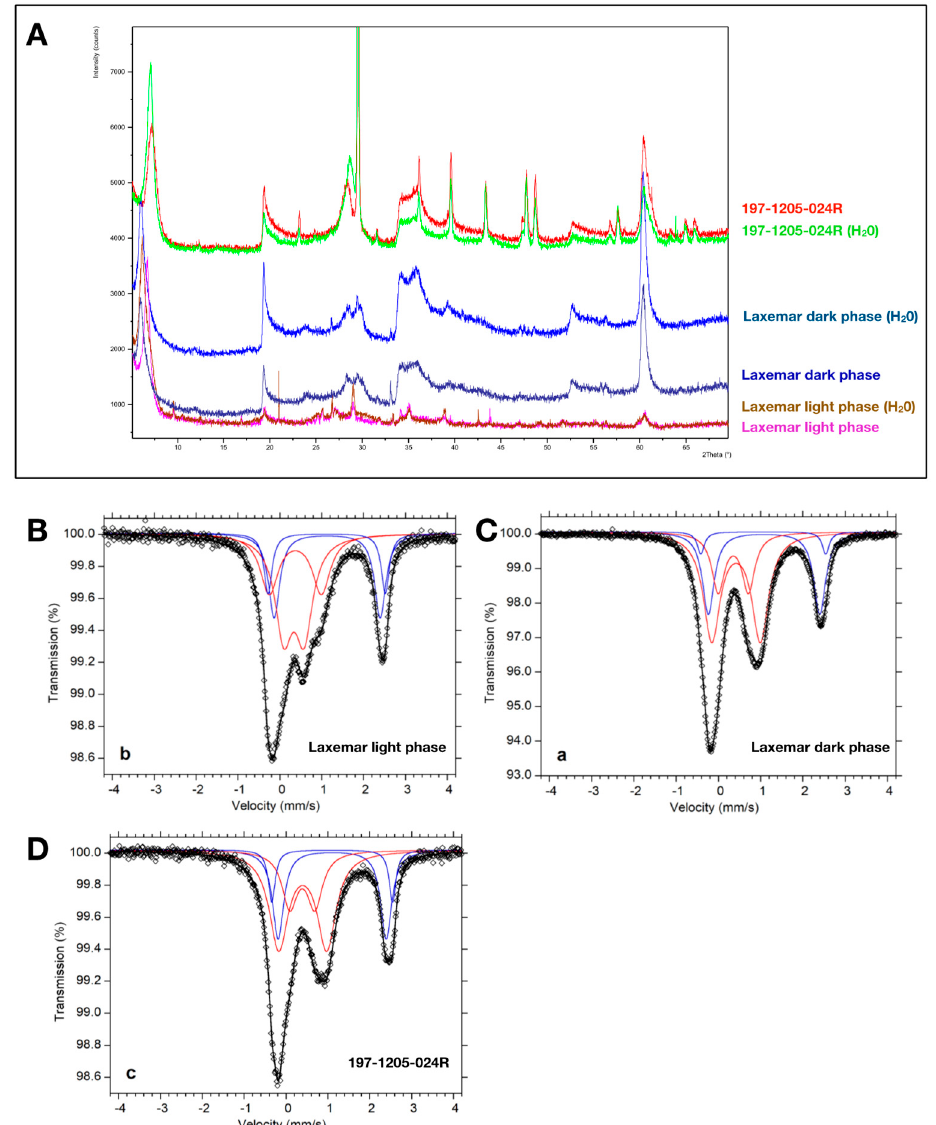
Figure 3. XRD ( A ) and Mössbauer spectra ( B – D ) of sample 1205A-024R (Nintoku seamount, clay mineralized hyphae) and two fungal biofilm samples (light and dark) from Laxemar, Sweden. ( A ) Summary of all XRD spectra encoded by color showing XRD peaks most closely related to smectites, in particular montmorillonite (there are also some peak matches with the smectite-group mineral saponite). ( B ) Mössbauer spectrum of light-colored clay mineralized fungal filaments from Laxemar. Diamonds represent the measured spectrum; the thick solid line represents the sum of the two fitted doublets (thin lines) assigned to Fe 3 + and Fe 2 + (Fe 2 + / Fe tot : 33.9%). ( C ) Mössbauer spectrum of slightly altered dark-colored clay mineralized biofilm from Laxemar. Diamonds represent the measured spectrum; the thick solid line represents the sum of the two fitted doublets (thin lines) assigned to Fe 3 + and Fe 2 + (Fe 2 + / Fe tot : 30.6%). ( D ) Mössbauer spectrum of green-colored clay mineralized fungal filaments from sample 1205A-024R, Nontoku seamount. Diamonds represent the measured spectrum; the thick solid line represents the sum of the two fitted doublets (thin lines) assigned to Fe 3 + and Fe 2 + (Fe 2 + / Fe tot :